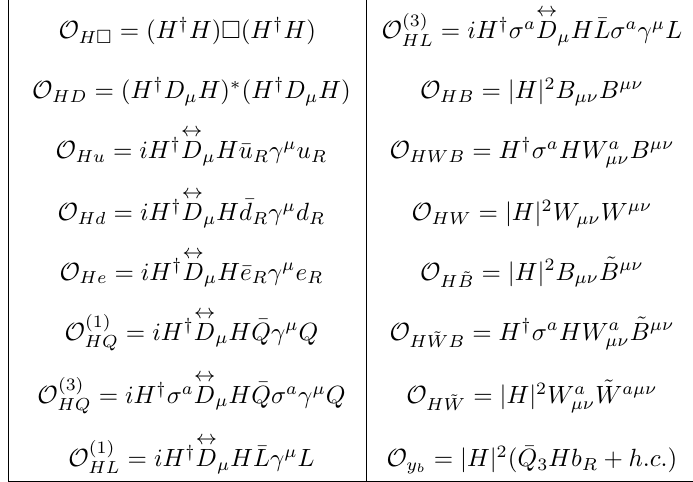
Table 1 . Dimension-6 operators in the Warsaw basis that contribute to the anomalous hV V (cid:3) =hV (cid:22) ff couplings in eq. (2.1). Other details regarding the notation can be found in